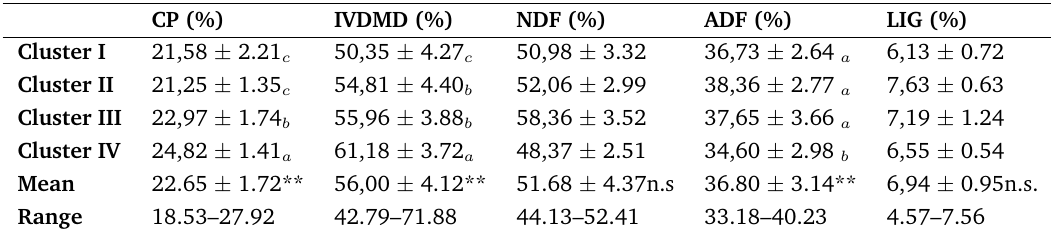
Table 7. Mean concentrations ± standard deviations of CP, IVDMD, NDF, ADF, and LIG of Stylosanthes scabra Vogel accessions distributed in four clusters. ** Significant differences among clusters at 0.01 α level. Means followed by the same subscript letter within the same column are not different, LSD - t student at 0.05 α level. CP, Crude Protein; IVDMD, In Vitro Dry Matter Digestibility; NDF, Neutral Detergent Fibre; ADF, Acid Detergent Fibre; LIG, Lignin.